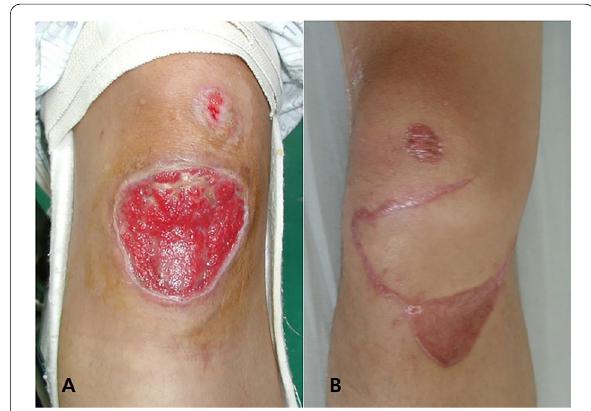
Fig. 2. a Clinical image showing a clear wound bed with fresh granulation tissue in the infrapatellar skin defect area. b Clinical image